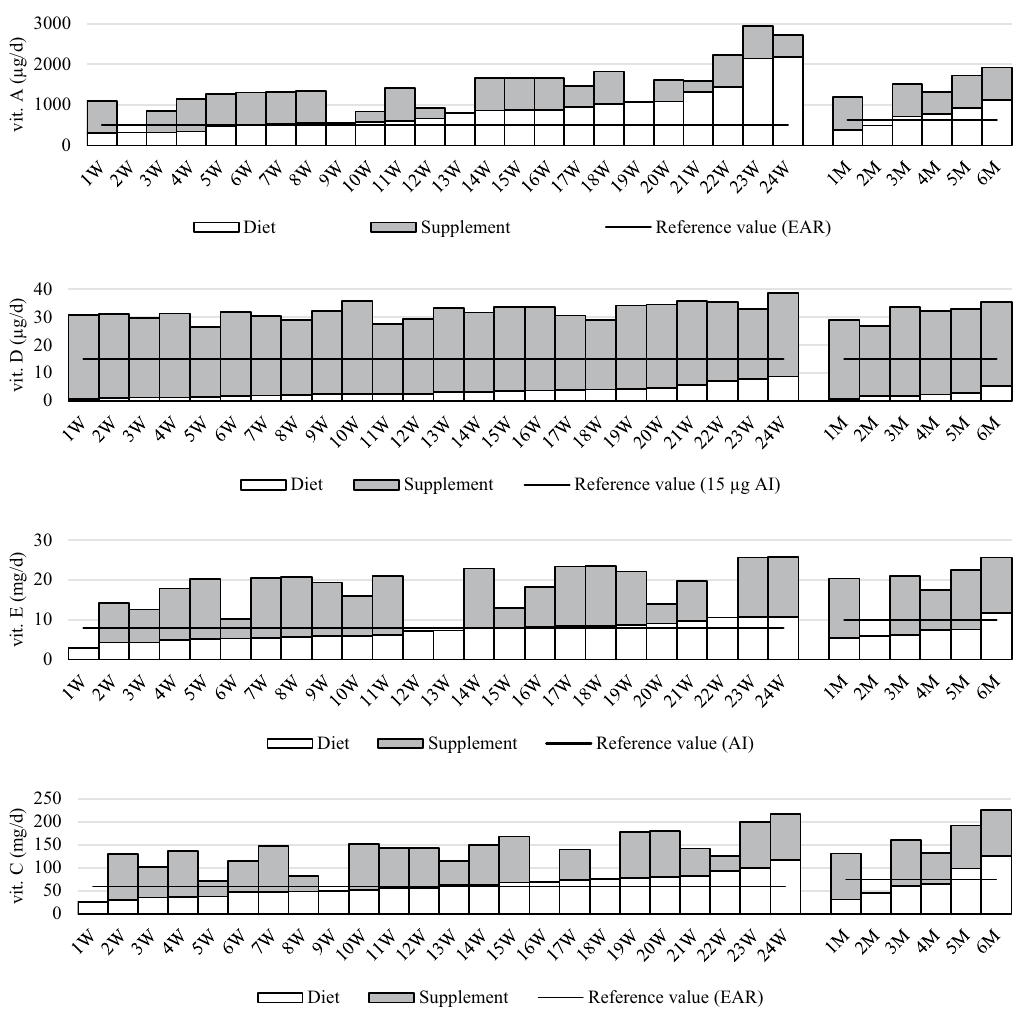
Figure 1. Mean dietary and supplement fat-soluble vitamins (A, D, E) and water-soluble vitamin C intakes by women ( W ) (n = 24) and men ( M ) (n = 6) tested at 3, 6 and 9 months after bariatric surgery (SG) (all data as µg or